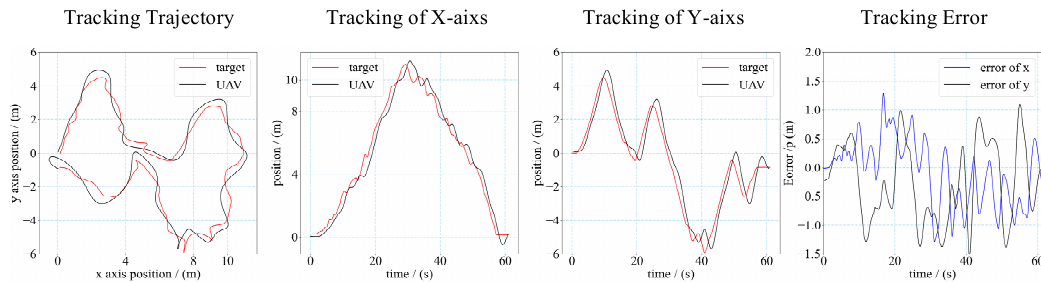
Figure 17. Trajectory and error of UAV tracking target. (The target moves randomly).